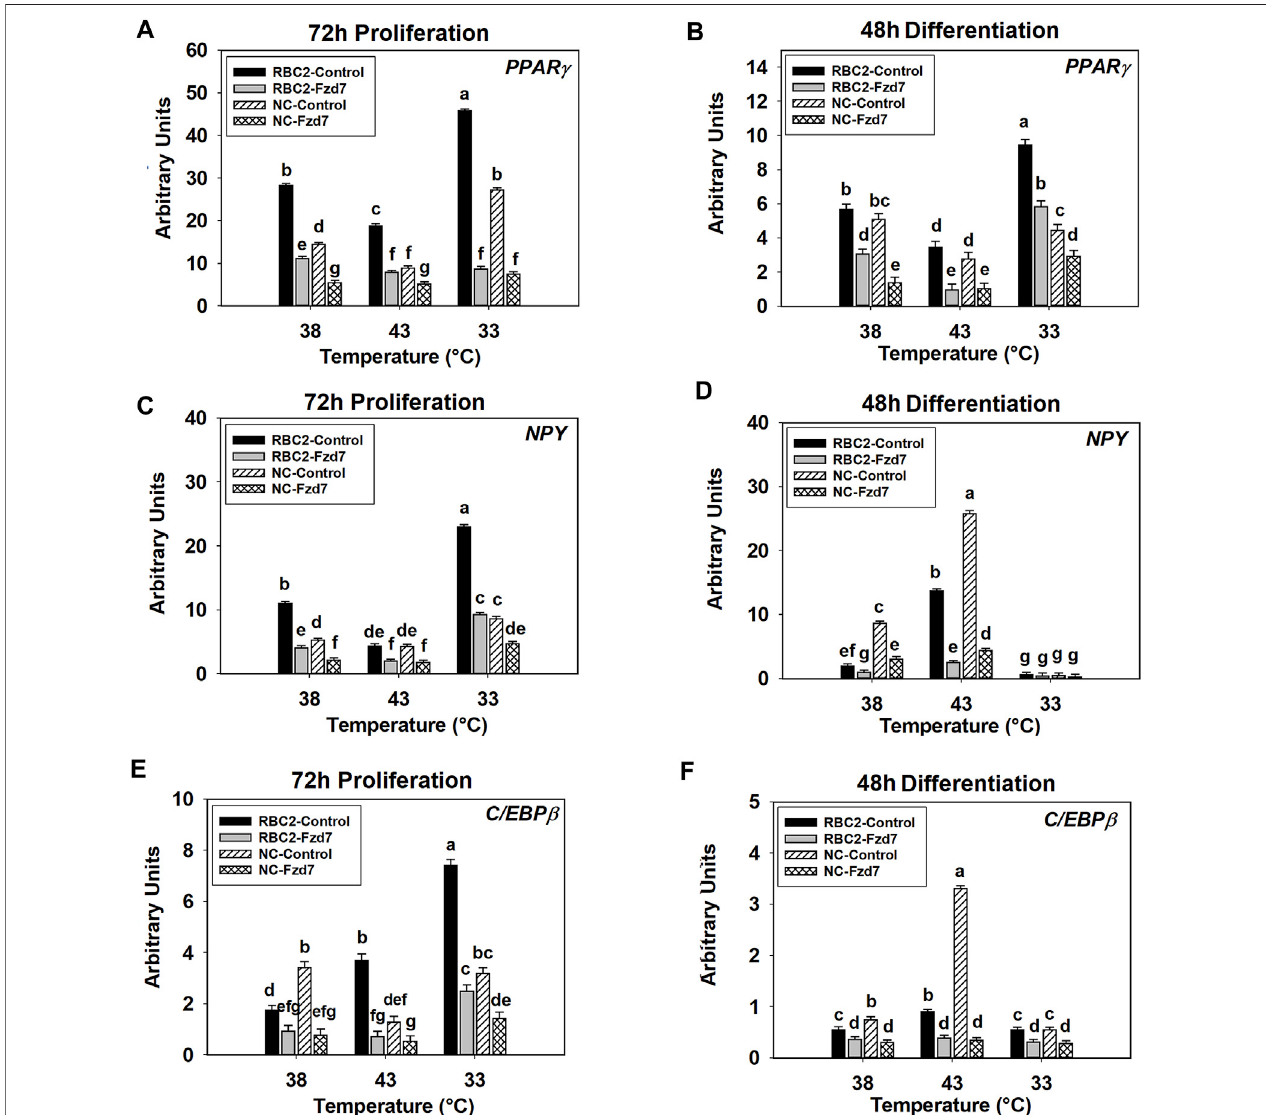
FIGURE 6 | Effect of hot and cold thermal stress and frizzled-7 ( Fzd7 ) knockdown on the expression of proliferator-activated receptor gamma ( PPAR γ ), neuropeptide-Y ( NPY ), and CCAAT/Enhancer-Binding Protein-Beta ( C/EBP β ) in satellite cells (SCs). After transfection with either a negative control siRNA or a siRNA targeting Fzd7 , both Randombred Control Line 2 (RBC2) and modern commercial (NC) line SCs proliferated at 38 ° C, 43 ° C, or 33 ° C. Expression of PPAR γ was determined at 72 h of proliferation (A) and 48 h of differentiation (B) . Expression of NPY was determined at 72 h of proliferation (C) and 48 h of differentiation (D) . Expression of C/EBP β was determined at 72 h of proliferation (E) and 48 h of differentiation (F) . Each graph bar represents a mean arbitrary unit, and each error bar represents a standard error of the mean. Mean values with different letters are signi fi cantly different ( p ≤ 0.05).